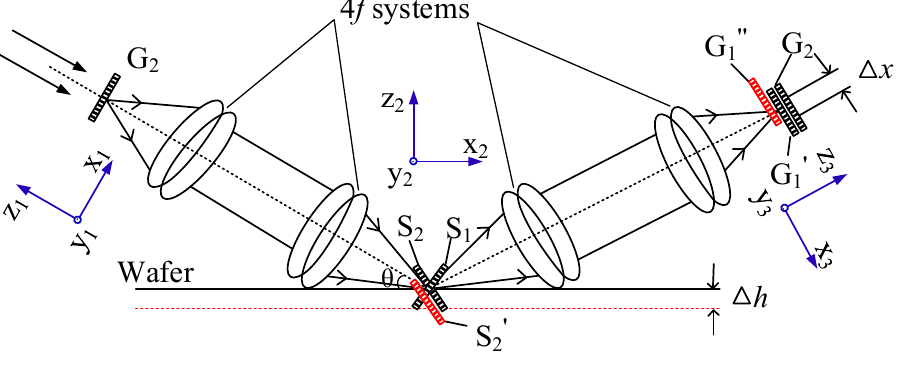
Figure 3. Schematic of Moiré fringe leveling and focusing scheme.